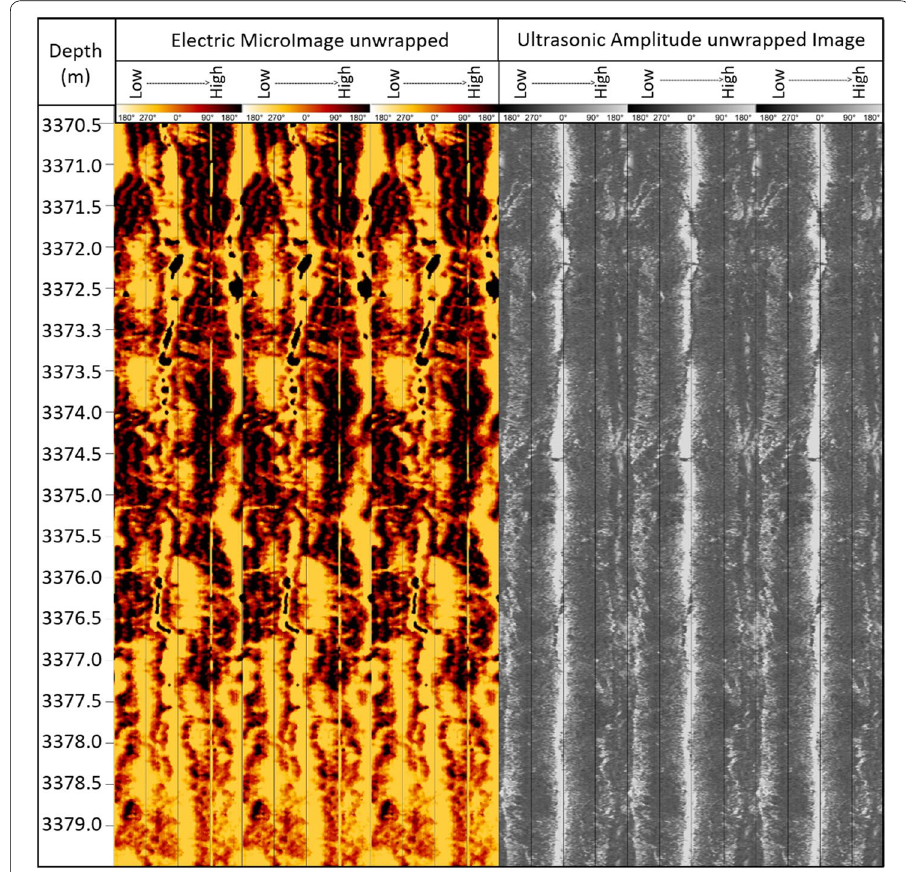
Fig. 3 Electrical microimage vs. ultrasonic image, side by side unwrapped three times. Vertical scale in meters. We can observe petal centerline structures extending from 3371.5 to 3374 m on both images (courtesy of Equinor and HS